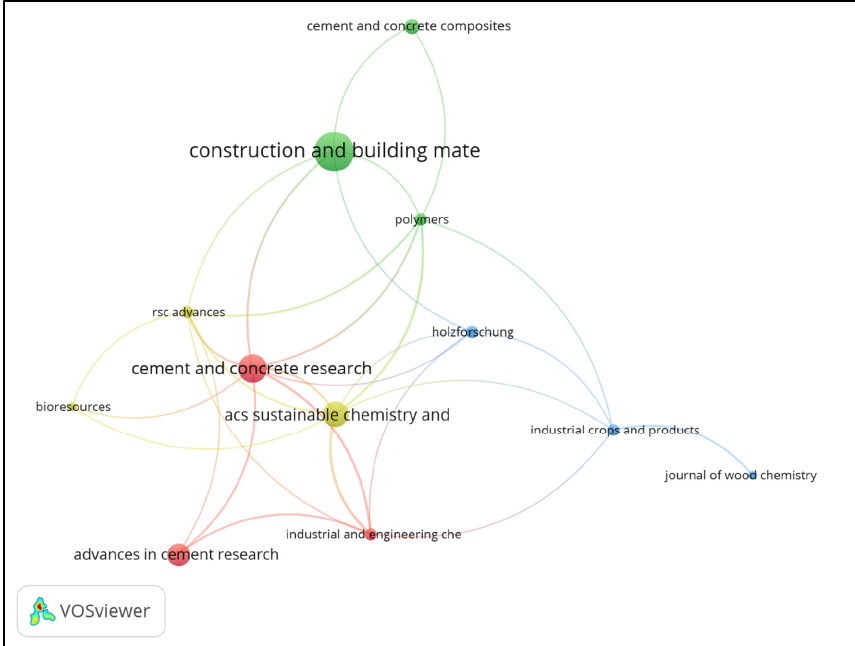
Figure 4. Science mapping of publication sources.